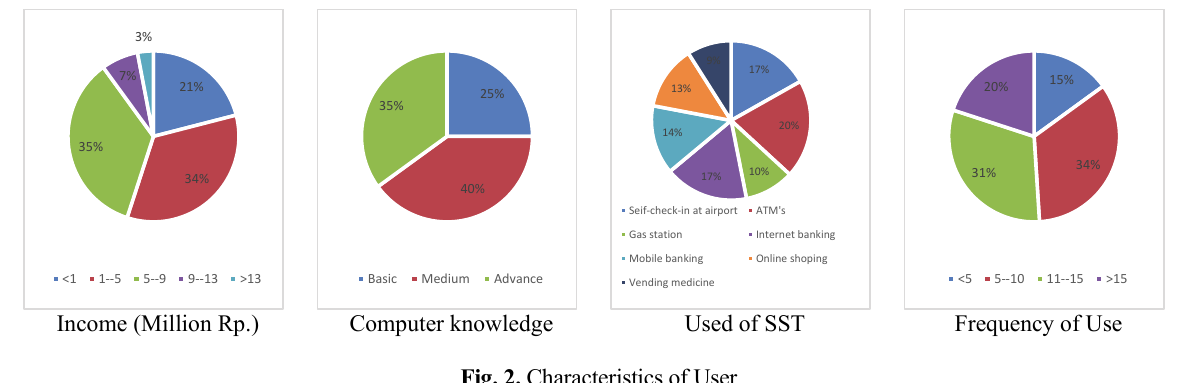
Fig. 2. Characteristics of